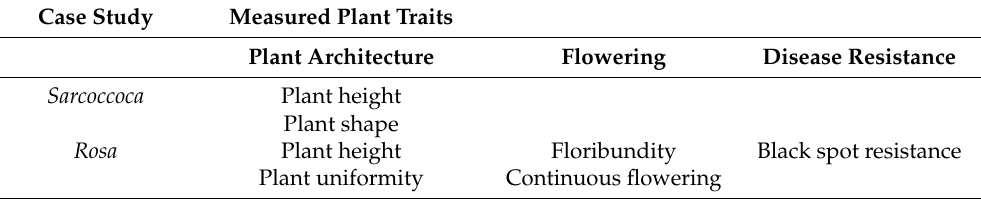
Table 1. Overview of the morphological characteristics evaluated for Sarcococca and Rosa . Case Study